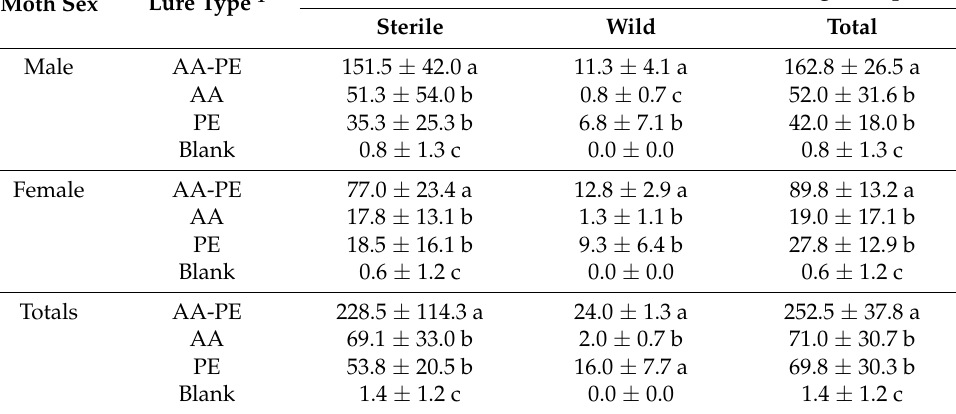
Table 1. Comparative seasonal catches of sterile and wild codling moths in white delta traps baited with acetic acid (AA) or ethyl-( E , Z )-2,4-decadienoate (pear ester (PE)) alone and in combination (AA-PE) in an apple orchard receiving weekly delivery of sterile